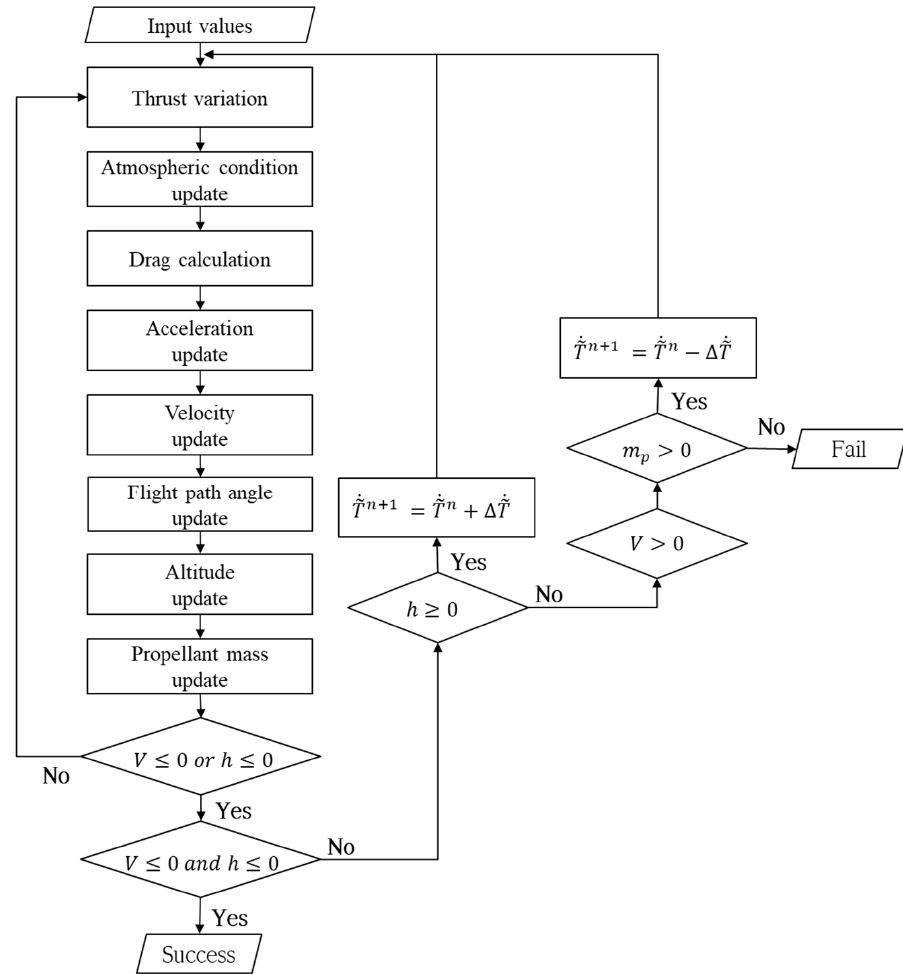
Figure 4. Calculation process of the landing-burn module. Table 5. Input and output parameters of the landing-burn modules.